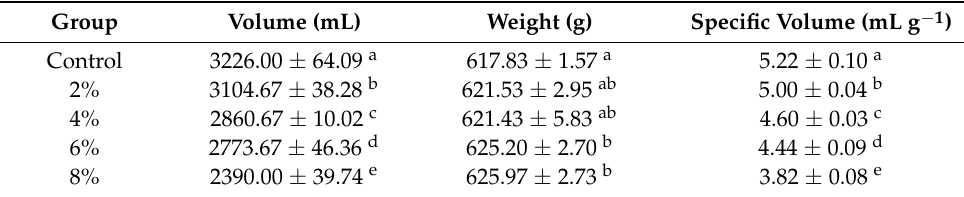
a–e : Means within the same column values with different superscript letters are significantly different ( p <